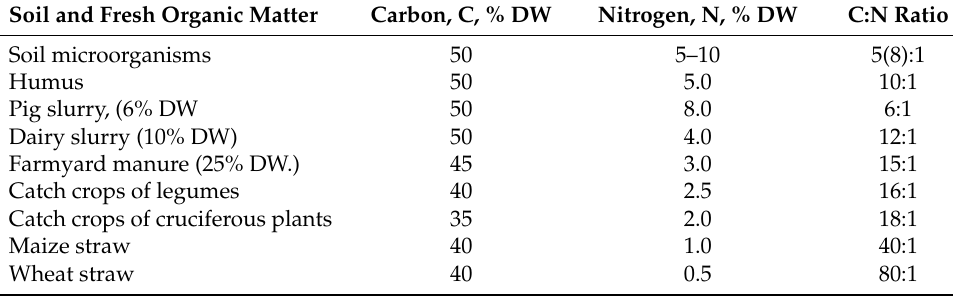
Table 4. The C:N ratio in the soil, crop residues, and manures introduced into the soil (the authors’ own calculation based on the basic data of various